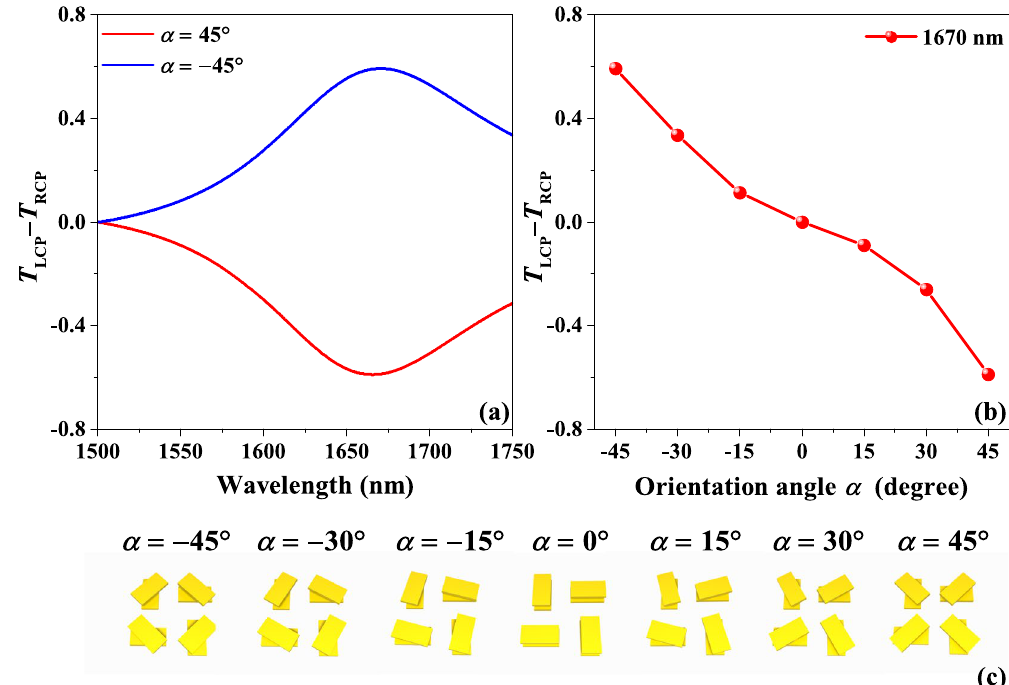
Figure 4. Characterizations of the chirality of the designed metasurfaces. ( a ) Simulation results for transmission difference Δ T = T LCP − T RCP of the two-layer metasurface with values of the orientation angle α of 45° and − 45°, respectively. ( b ) Engineering of the transmission difference by orientation angle. ( c ) Schematic diagrams of various two-layer metasurfaces with different orientation angles in 15° increments from − 45° to 45°.